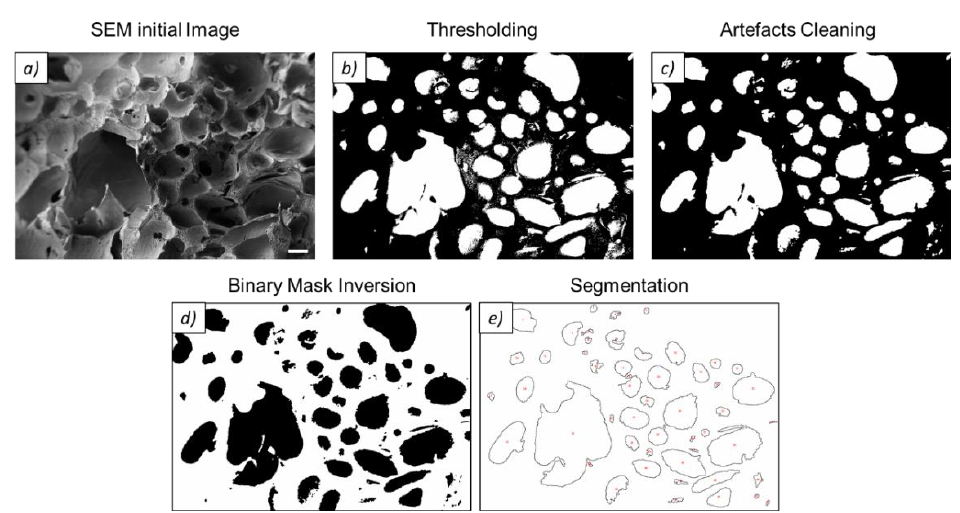
Figure 3. The workflow of the pore analysis in Fiji. Starting from the SEM initial image ( a ), thresholding was applied with the percentile method ( b ). Subsequent artifact cleaning ( c ) and binary mask inversion ( d ) were applied before the segmentation process ( e ). Detected porosity along the frame edges was excluded.